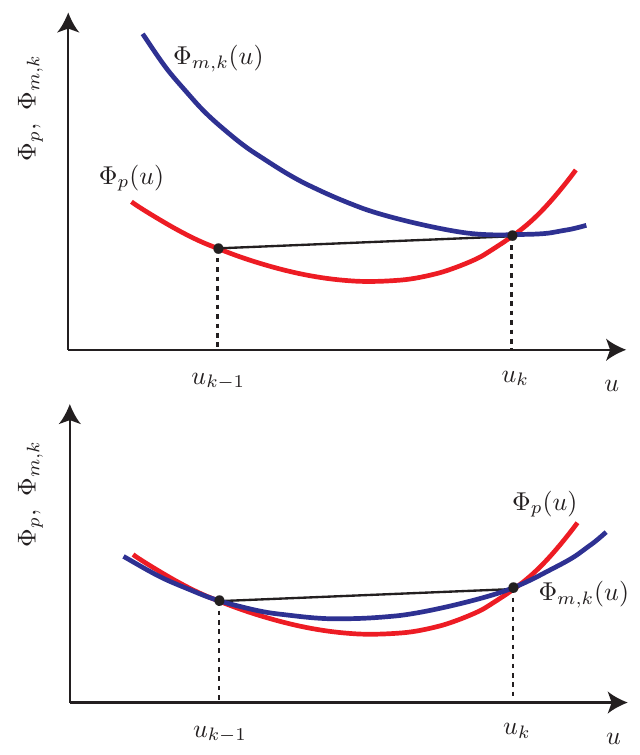
Figure 3. Approximation of the plant cost function. Top plot: Modified cost using gradient from FDA; Bottom plot: Modified cost using linear interpolation.